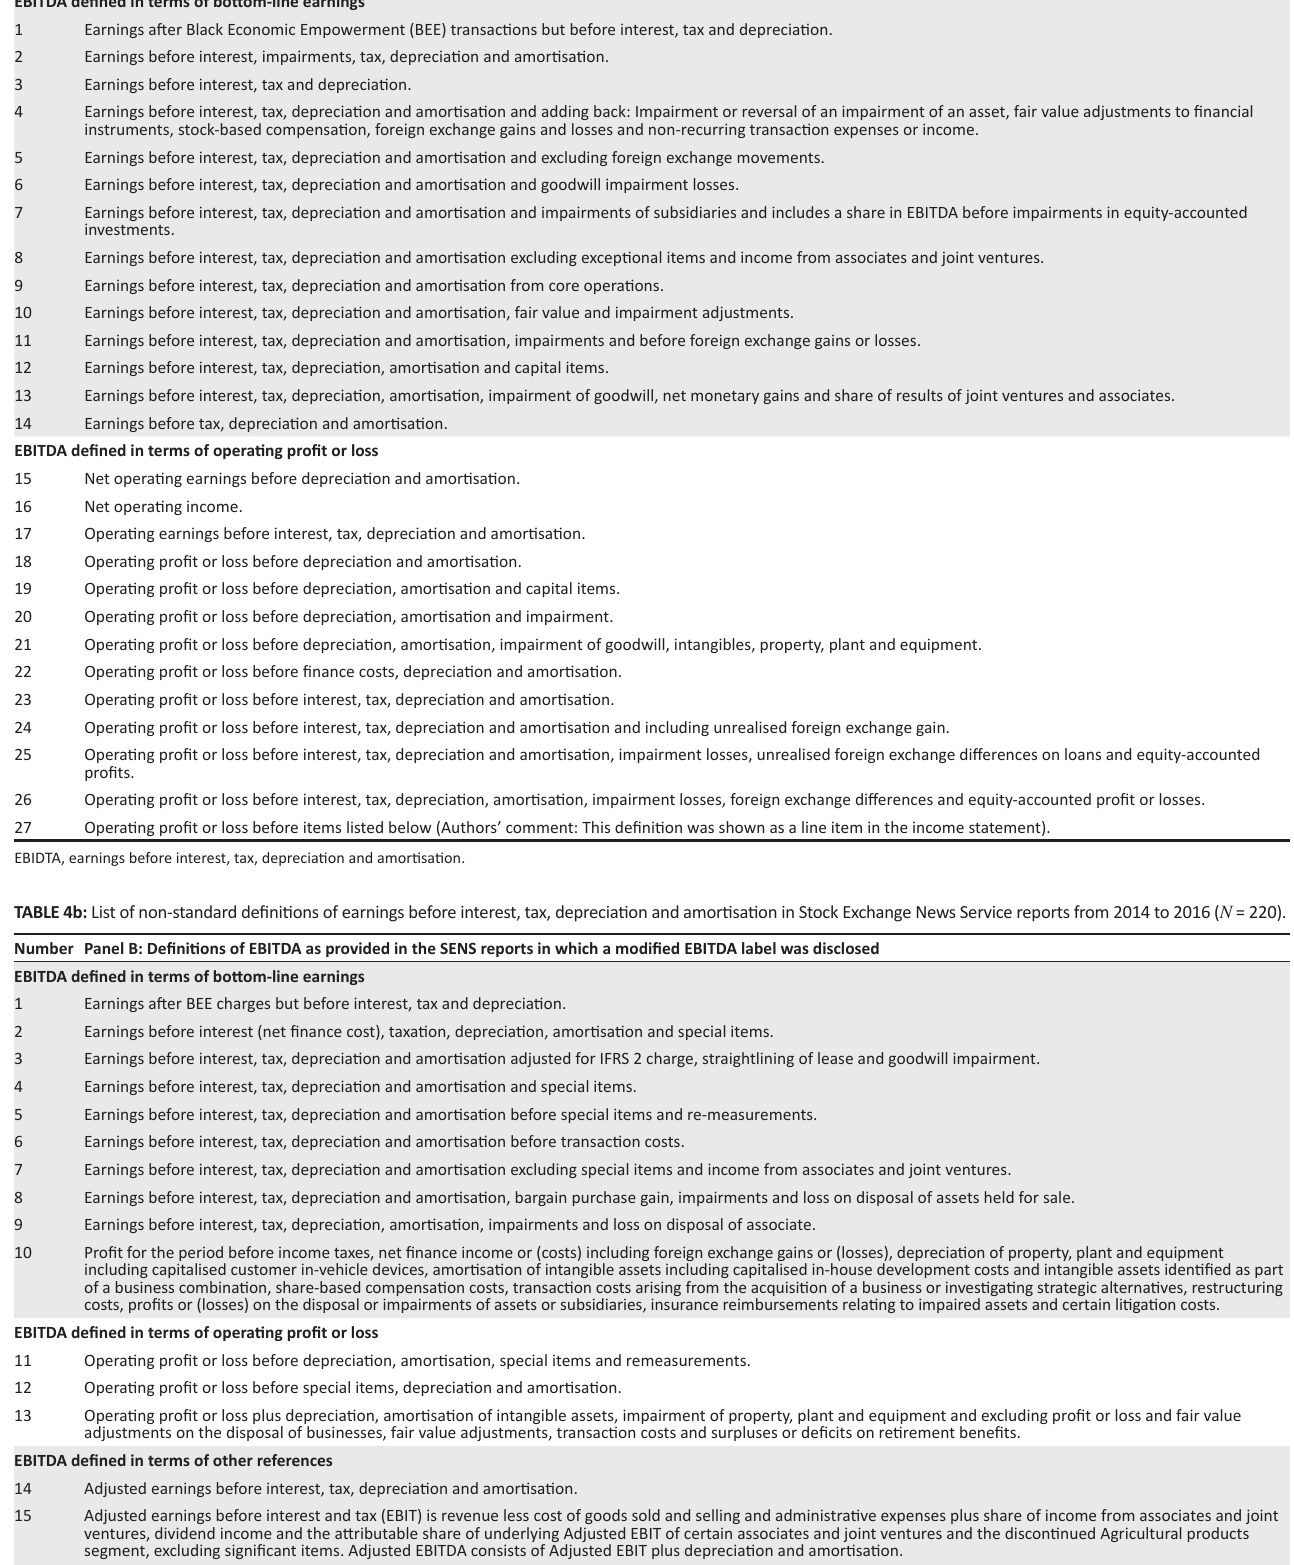
TABLE 4a: List of non-standard definitions of earnings before interest, tax, depreciation and amortisation in Stock Exchange News Service reports from 2014 to 2016 ( N = 220). Number Panel A: Definitions of EBITDA as provided in the SENS reports in which an unmodified EBITDA label was disclosed EBITDA defined in terms of bottom-line earnings